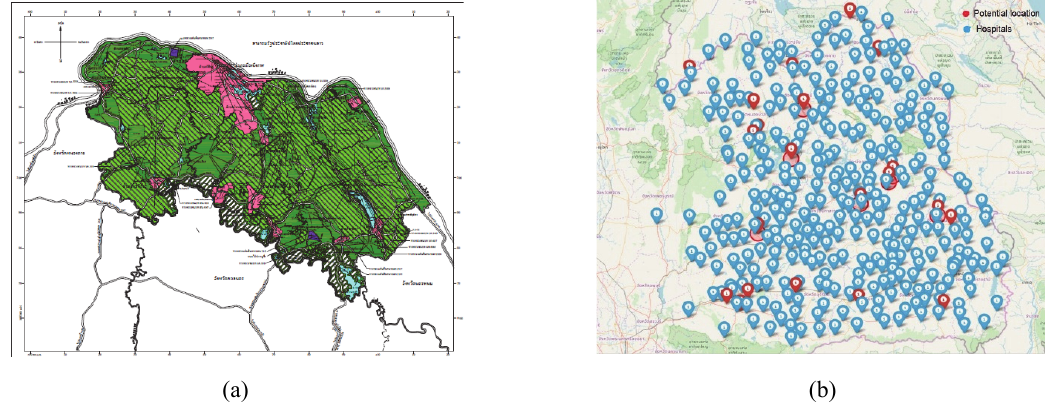
Fig. 1. (a) The example of the comprehensive city plan and (b) the potential locations and hospitals in the Northeast of